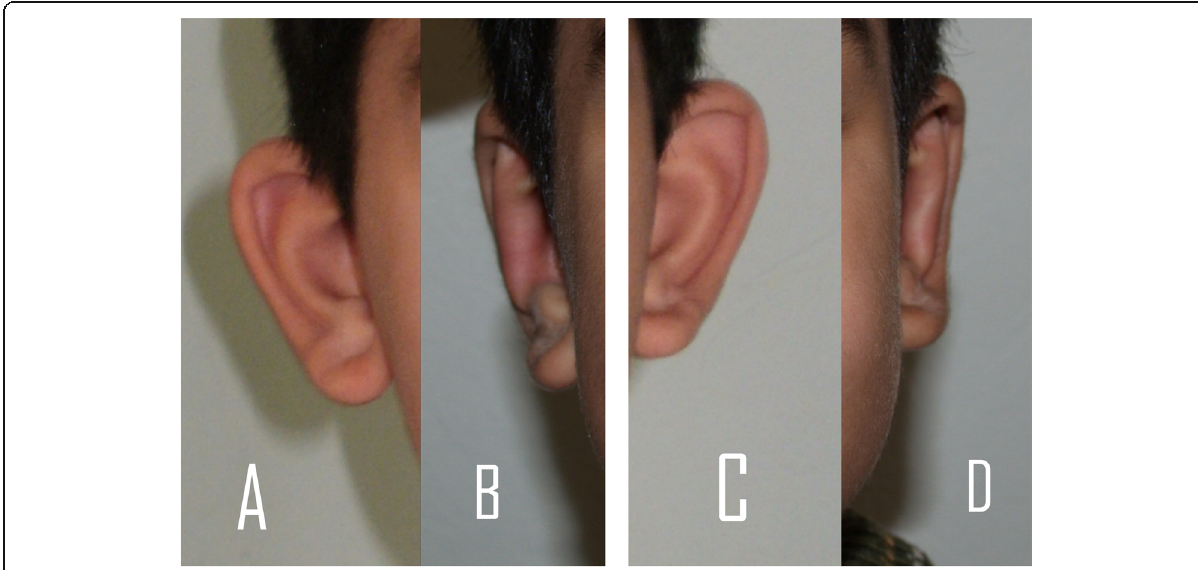
Fig. 9 Preoperative picture of the right and left ears ( a , c ) for a 6-year-old child with a bilateral prominent ear deformity with a 1-year postoperative follow-up ( b , d